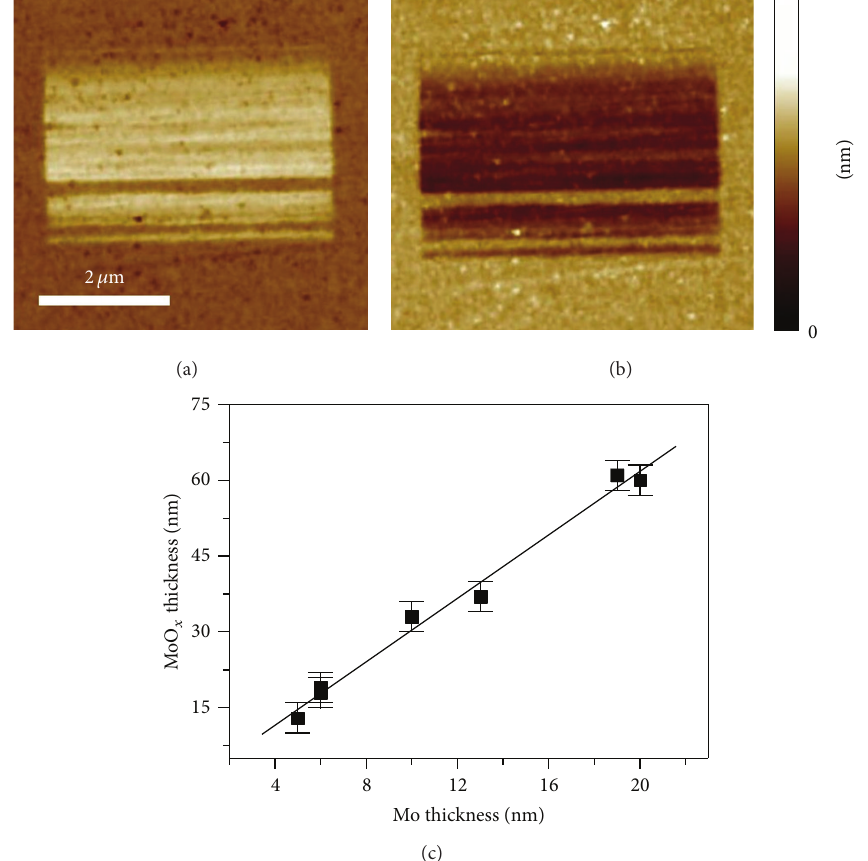
Figure 4: (Color online) Topographic AFM images of square-like oxidized regions via LAO process in Mo film, (a) just after applying LAO process and (b) subsequent to washing out the oxide in deionized water. (c) A graph showing Mo oxide versus Mo thicknesses revealing the ratio MoO 𝑥 /Mo as 3.2 ±